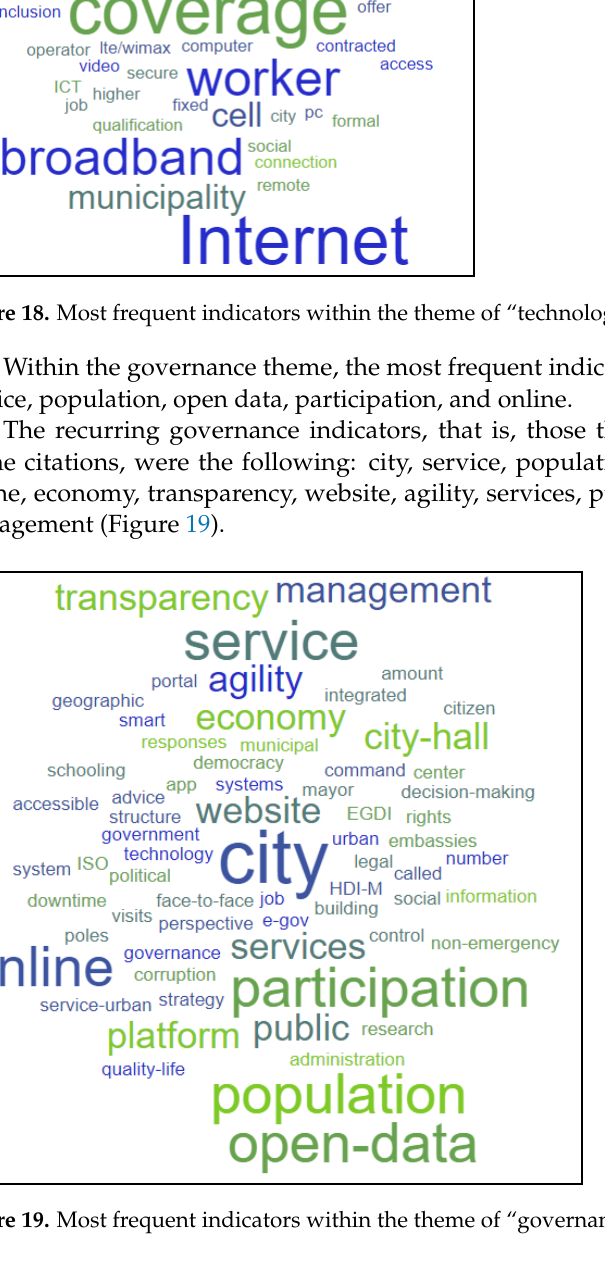
Figure 17. Most frequent indicators within the theme of “mobility”.